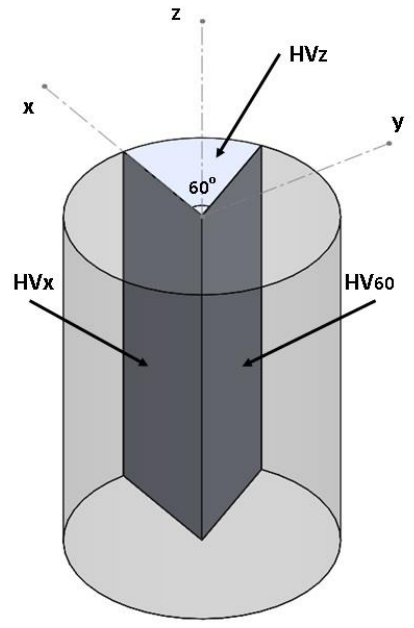
Table 4. Oxygen content in powder, in as-built and treated samples (the data acquired from [18]) S1 sample—as-built from Sample “Virgin” powder “virgin” powder Figure 2. Samples cutting for microhardness test. Figure 2. Samples cutting for microhardness test.